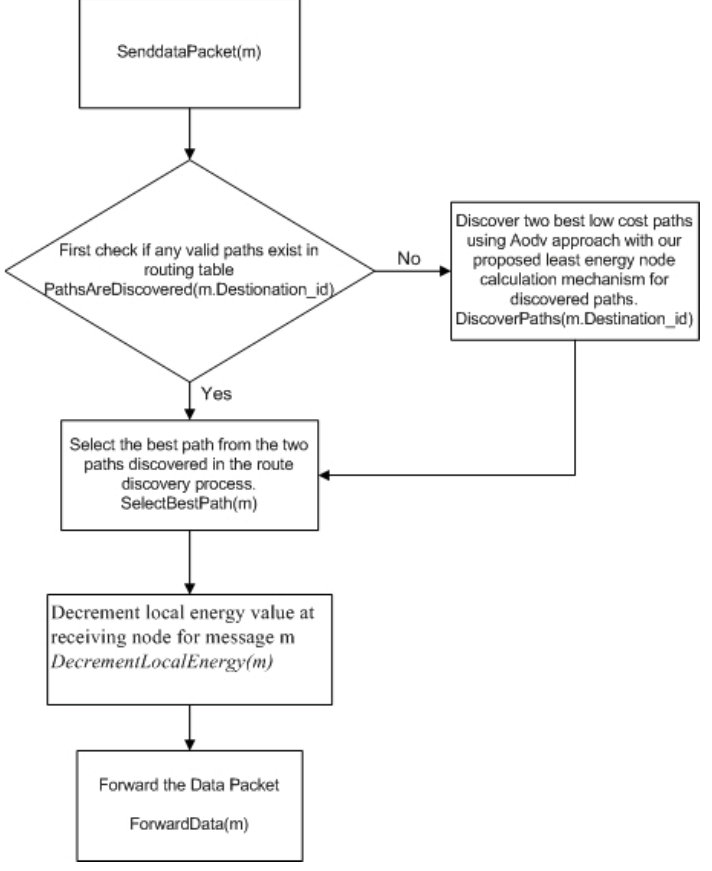
Figure 7. Overall procedure for the sender node to send data packet.